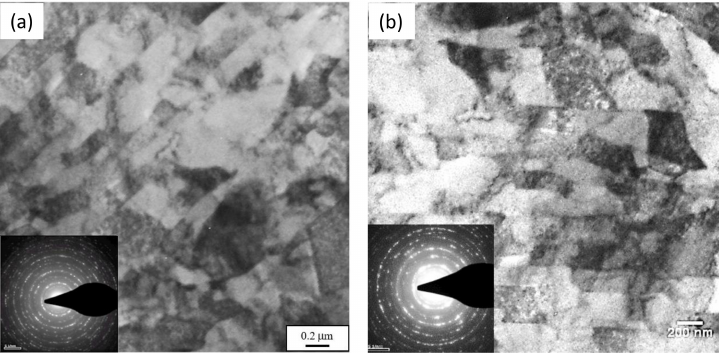
Figure 5. Comparison of the microstructure at two locations: ( a ) plane C , ( b ) near the free